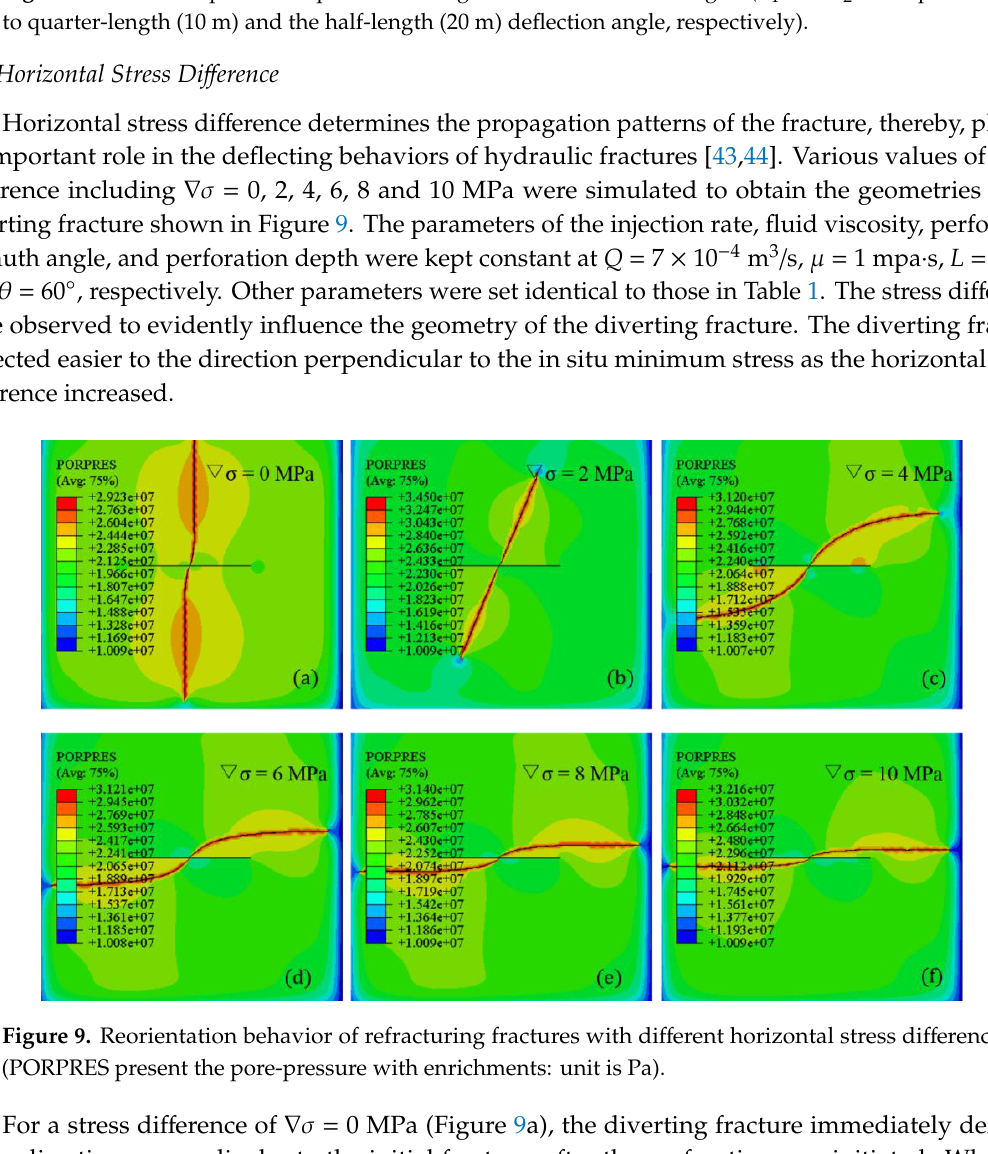
Figure 8. Relationship between perforation angle and two deflection angles ( θ 1 and θ 2 corresponding to quarter-length (10 m) and the half-length (20 m) deflection angle, respectively).